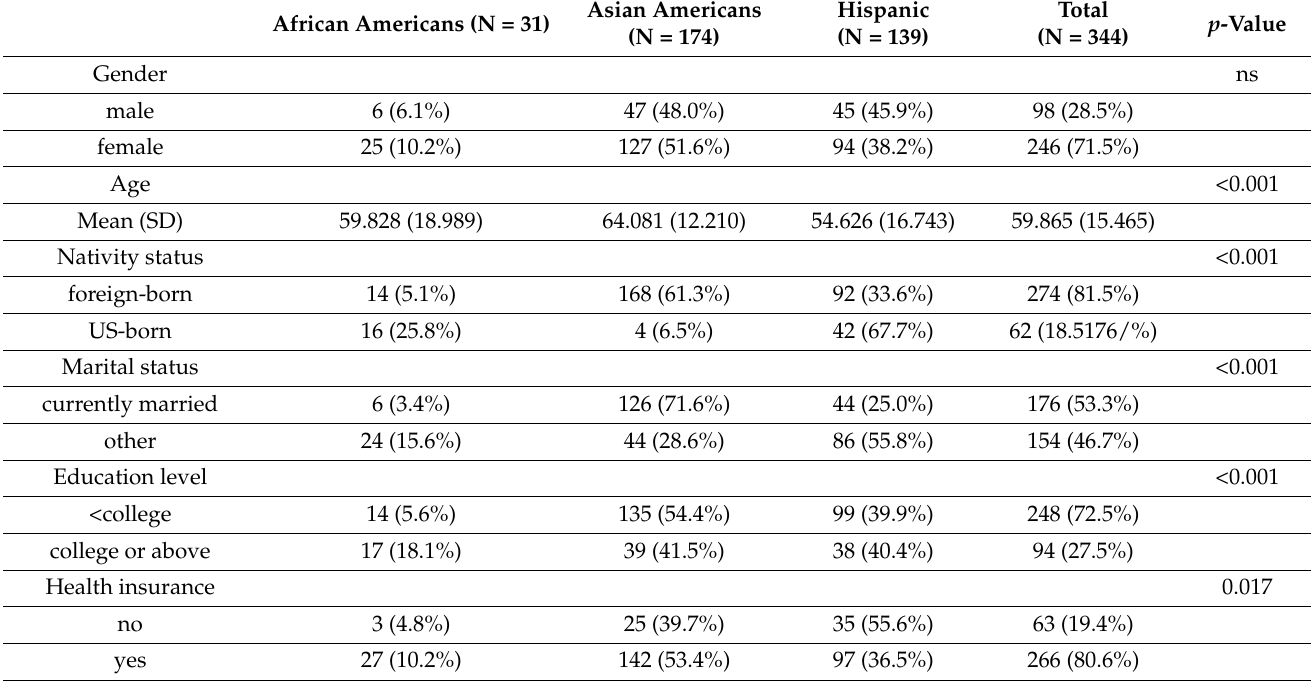
Table 1. Demographic characteristics by racial/ethnic groups.